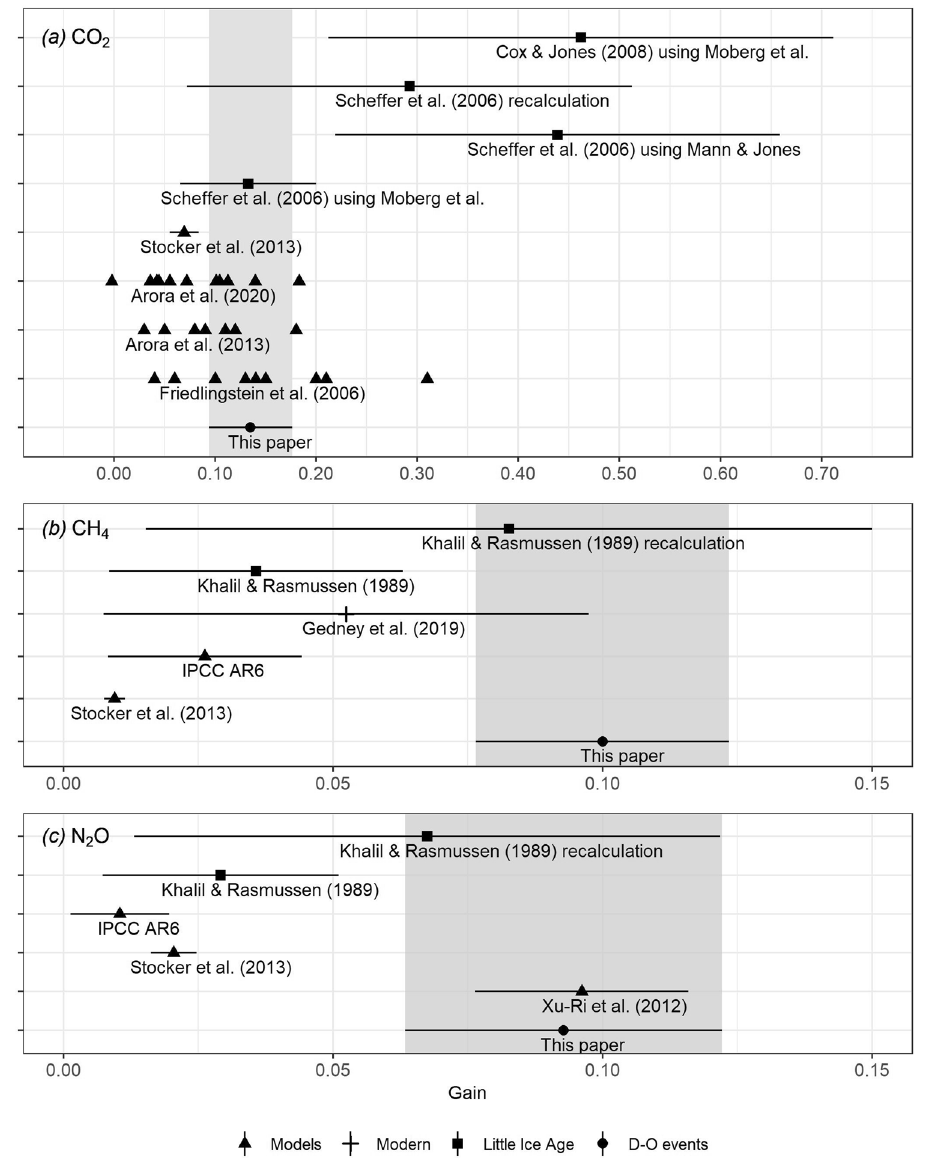
Fig. 4 Comparison of gains. Gains of this paper and previous estimates for ( a ) CO 2 , ( b ) CH 4 and ( c ) N 2 O. Horizontal lines show the 95 % con fi dence intervals on each estimate. The shaded bars show the estimates from this paper, using 3.23 ± 0.66 K as the ECS. All the models estimate feedbacks at 2100. Stocker et al. 11 only simulates the land climate feedbacks. The recalculated estimates for the Little Ice Age are based on the full 7000-member ensemble of global mean temperature reconstructions provided by the PAGES2k Consortium, using the 95% range to approximate 95% con fi dence